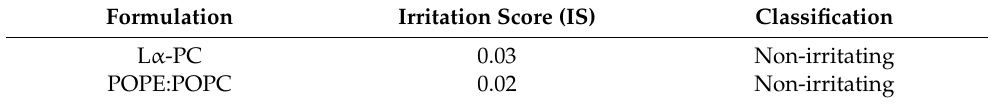
Table 7. Irritation score (IS) of the liposomes tested by the HET-CAM technique. Formulation Irritation Score (IS) Classification L α -PC 0.03